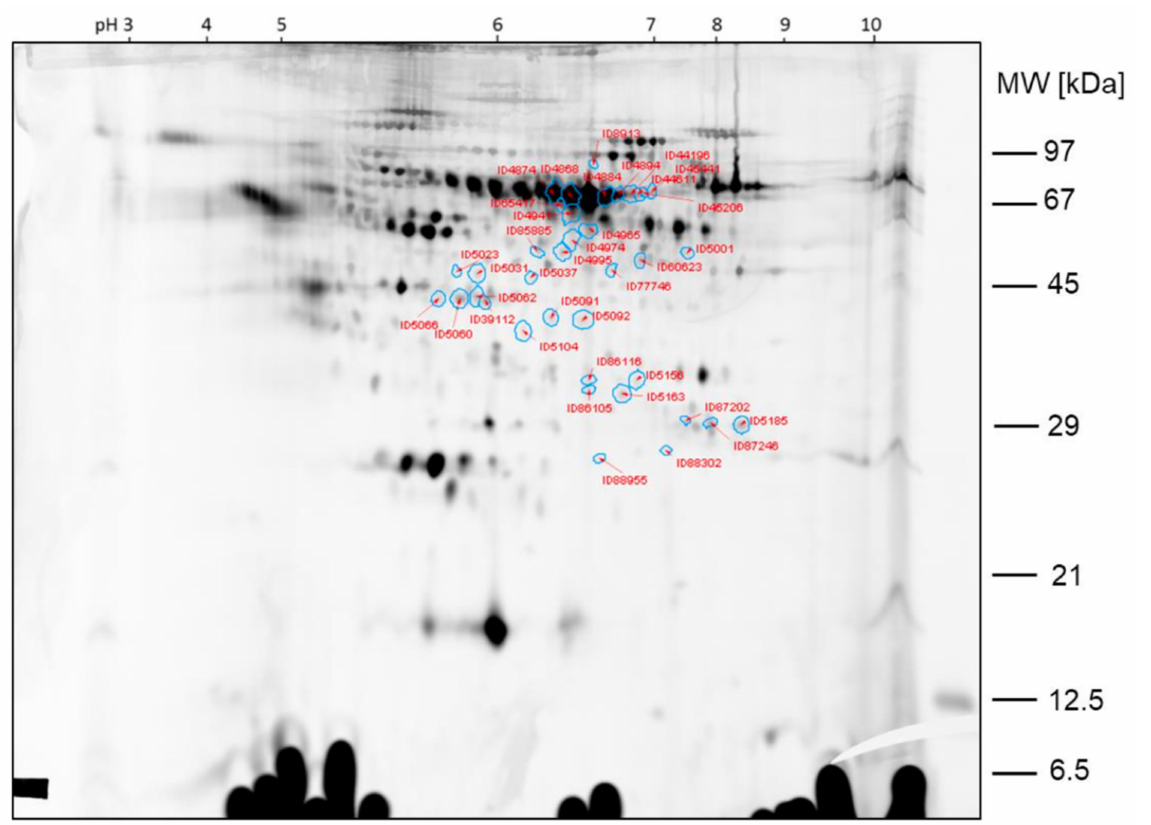
Figure 11. Comparison 3: Spots found >2-fold higher expressed in sample hypobaric hypoxia 60 min. Spots after filtering.